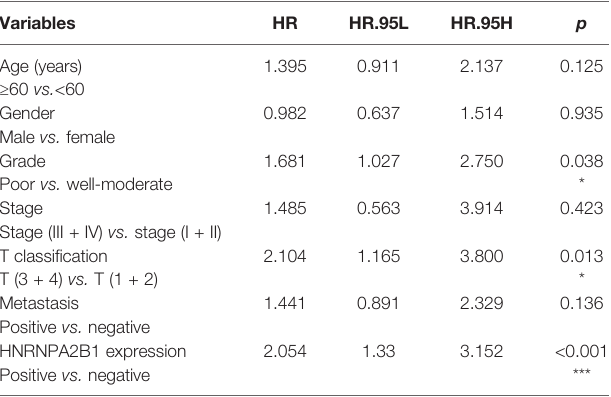
TABLE 1 | Statistical analyses of factors associated with survival in OSCC patients with the multivariate Cox proportional hazards models.